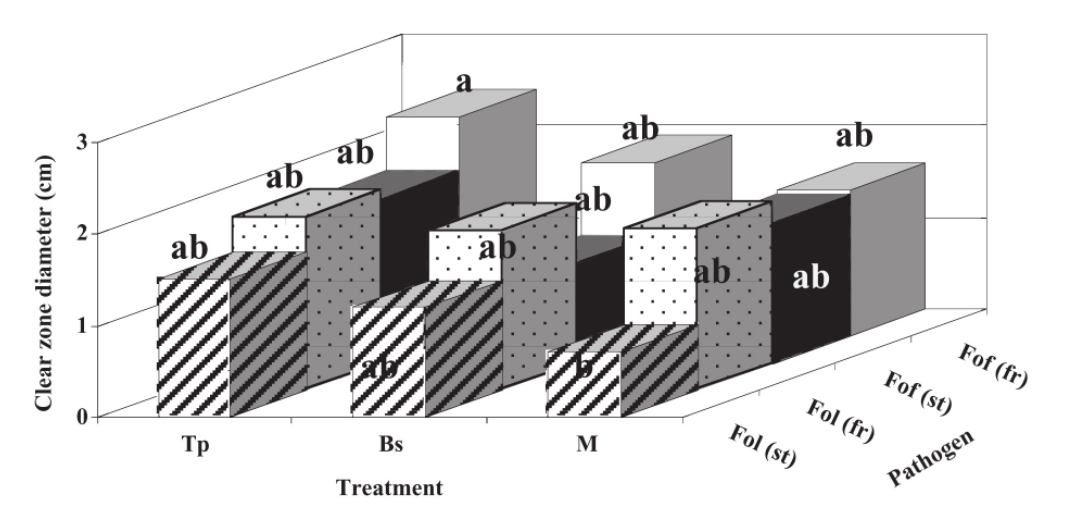
Fig. 2. Effect of filtrate of the biocontrol agents on the growth of the pathogens in vitro (expressed as clear zone diameter). LSD=1.2902. Means with the same letters are not significantly different ( P =0.05). Tp, Trichoderma pseudo- koningii ; Bs, Bacillus subtilis ; M, Mixture of these two organisms; Fof (fr), Fusarium oxysporum f. sp. fabae , fresh filtrate; Fol (fr), F. oxysporum f. sp. lupini , fresh filtrate; Fof (st), F. oxysporum f. sp. fabae , stored filtrate; Fol (st), F. oxysporum f. sp. lupini , stored